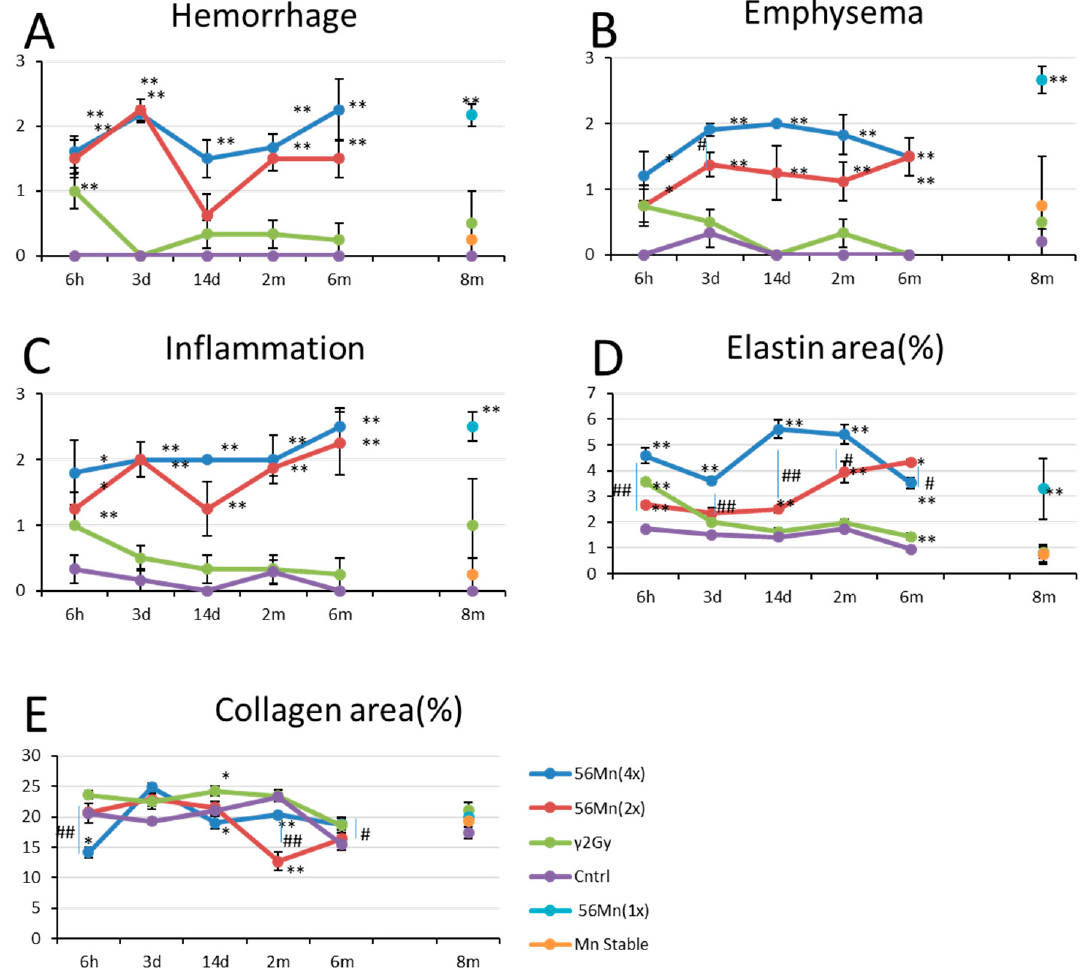
Figure 2. Histological scored findings in the lung in rats exposed to Mn stable, 56 Mn, γ 2.0 Gy and Control groups. ( A ) shows hemorrhage findings for four groups γ 2.0 Gy, 56 Mn(2 × ), 56 Mn(4 × ) and control and findings γ 2.0 Gy, Mn stable, 56 Mn1( × ) and control; ( B ) shows findings for emphysema for the same experiments; ( C ) shows the inflammation findings for the same experiments; ( D ) shows the elastin findings for the same experiments; ( E ) shows the collagen findings for the same experiments. Bars, mean ± SEM ( n = 3–6). * p < 0.05, ** p < 0.01 vs. Control. # p < 0.05, ## p < 0.01 vs. 56 Mn(2 × ).